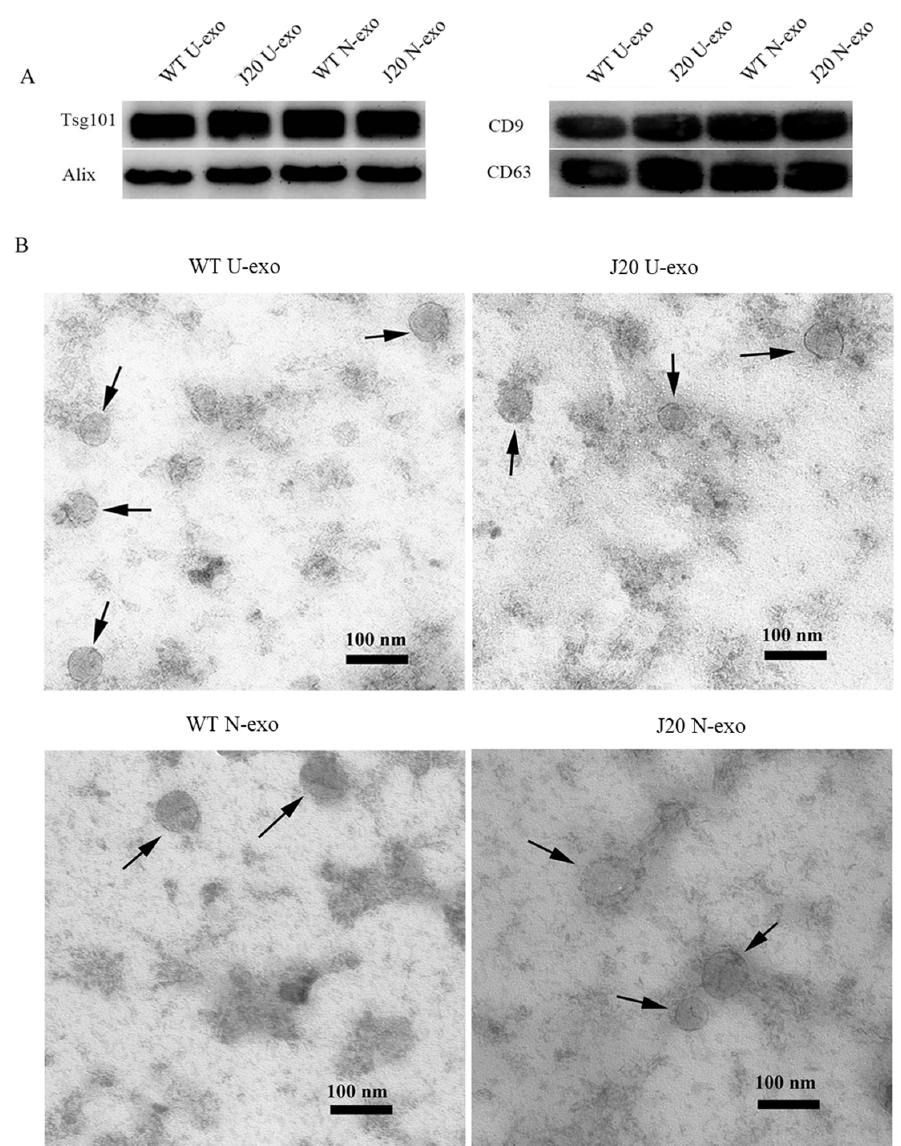
Figure 1. Characterization of isolated exosomes. ( A ) Western blotting for detecting the exosomal markers of U-exo and N-exo. ( B ) Transmission electron microscope for imaging of U-exo and N-exo. U-exo: urine exosomes. N-exo: neuron-derived